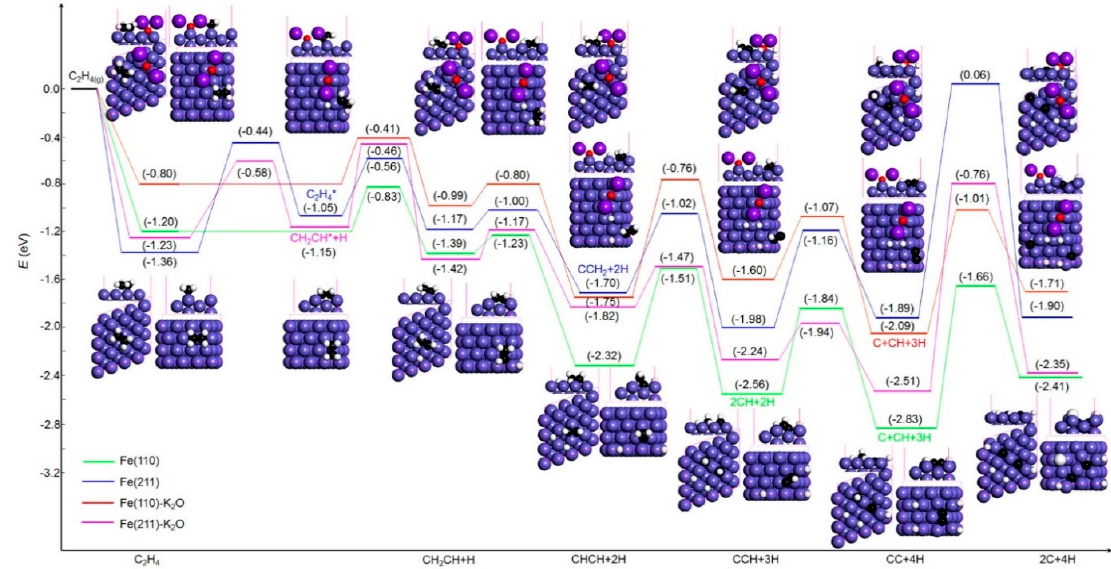
Figure 3. The most favorable pathways of C 2 H 4 / C 2 H 2 dissociation on the Fe(110), Fe(110)-K 2 O, Fe(211) and Fe(211)-K 2 O, as well as the top and side view configurations of the corresponding intermediates. The Fe, K, O, C and H atoms are given in grayish blue, purple, red, black and white, respectively.